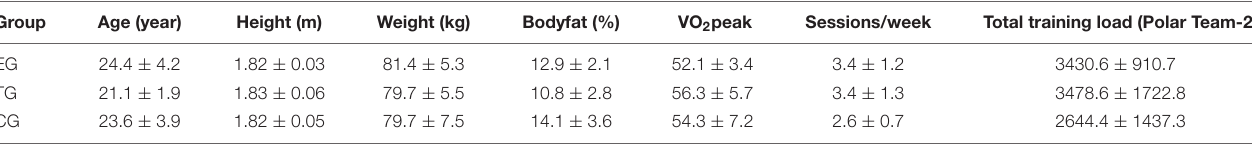
TABLE 1 | Anthropometric data (mean ± SD ) and total training load (arbitrary units) during the 7-week intervention period calculated by Polar Team-2 Software according to training time spent in defined heart rates (see the section “Materials and Methods”). Group Height (m) Weight